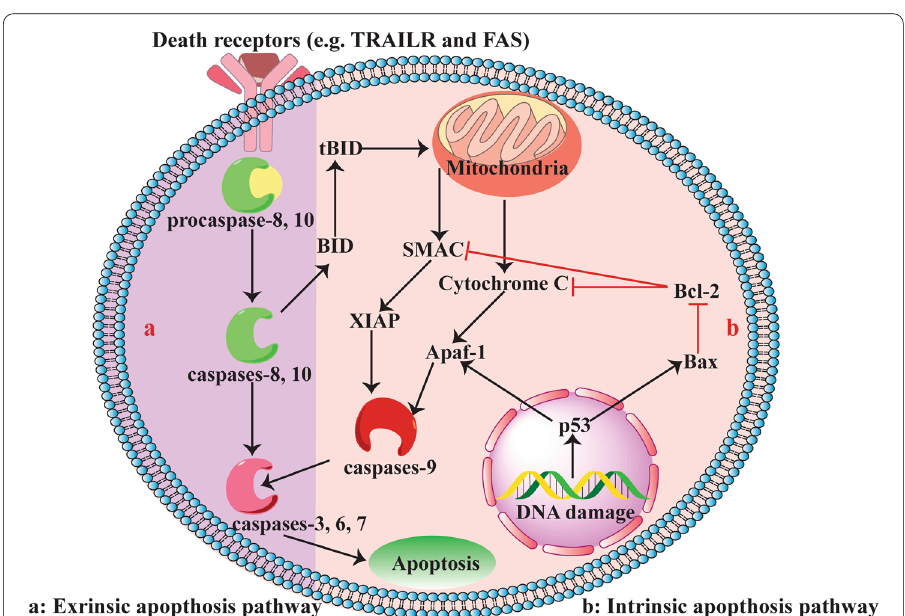
Fig. 4 The molecular mechanisms underlying intrinsic and extrinsic apoptosis